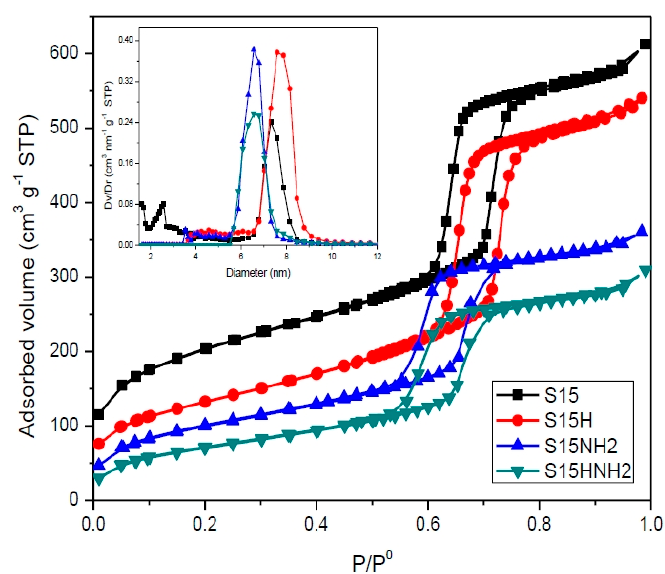
Figure 9. N 2 sorption isotherms at 76 K and pore size distribution curves (figure inset) of SBA-15 substrates: S15, S15H, S15NH 2 , and S15HNH 2 . P/P 0 is the relative pressure, while P 0 represents the saturation pressure, finally STP means Standard Temperature and Pressure. Table 1. Textural properties obtained from N 2 sorption at 76